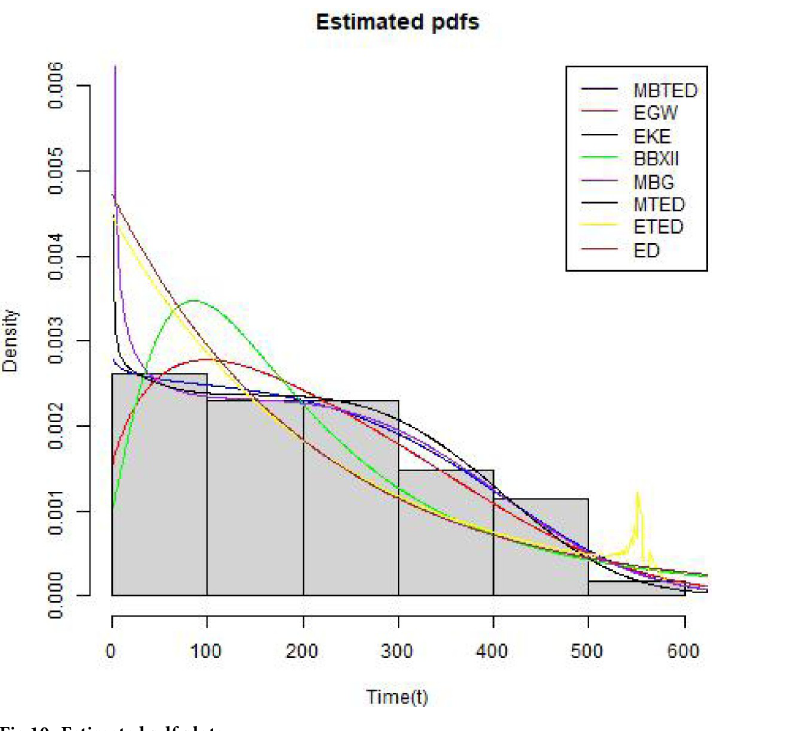
Fig 10. Estimated pdf plots.